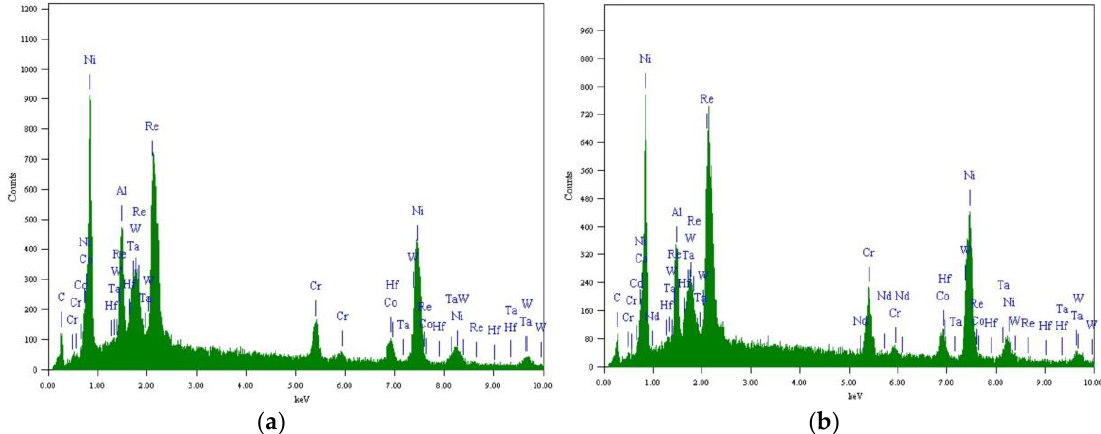
Figure 6. Element distribution of ( a ) domain A and ( b ) domain B in Figure 5b.